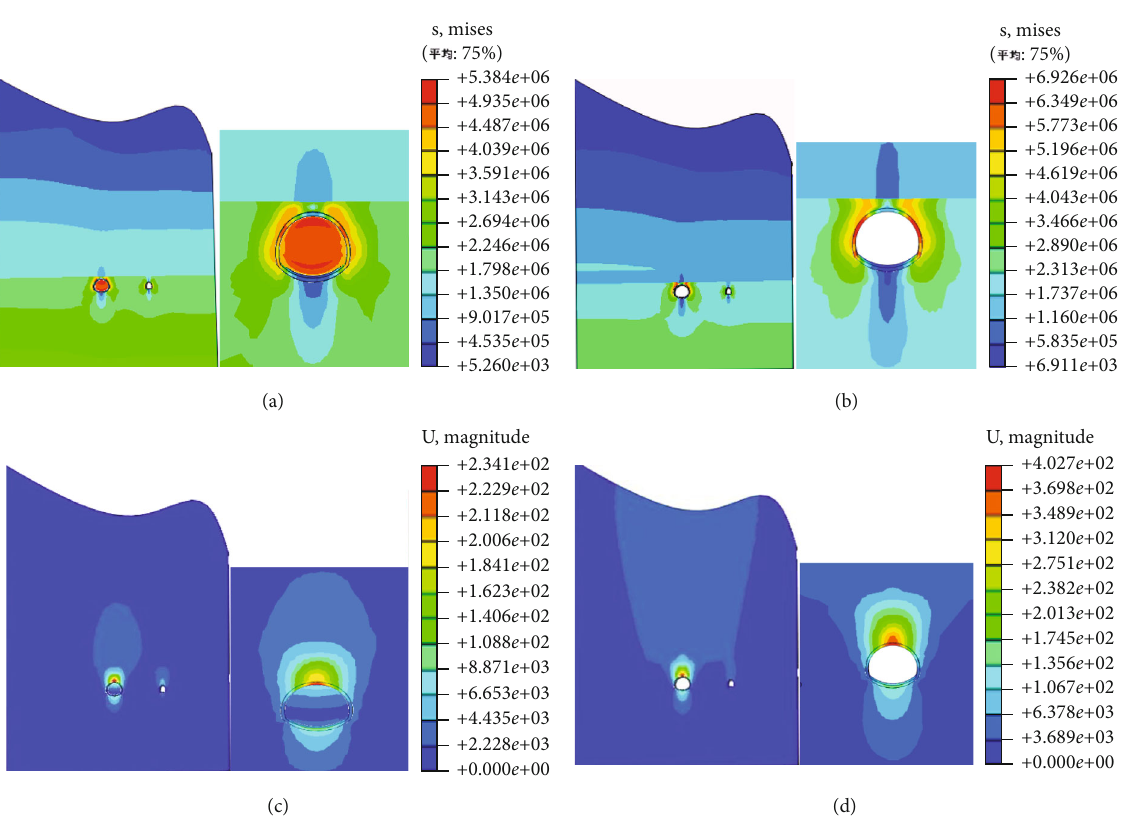
Figure 6: Stress diagram and displacement diagram of full section of tunnel crossing coal seam: (a) step 8: excavation stress diagram, (b) step 10: excavation stress diagram, (c) step 8: excavation displacement diagram, and (d) step 10: excavation displacement